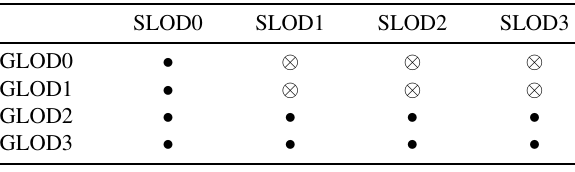
Figure 3. Permissible combinations of SLOD and GLOD per